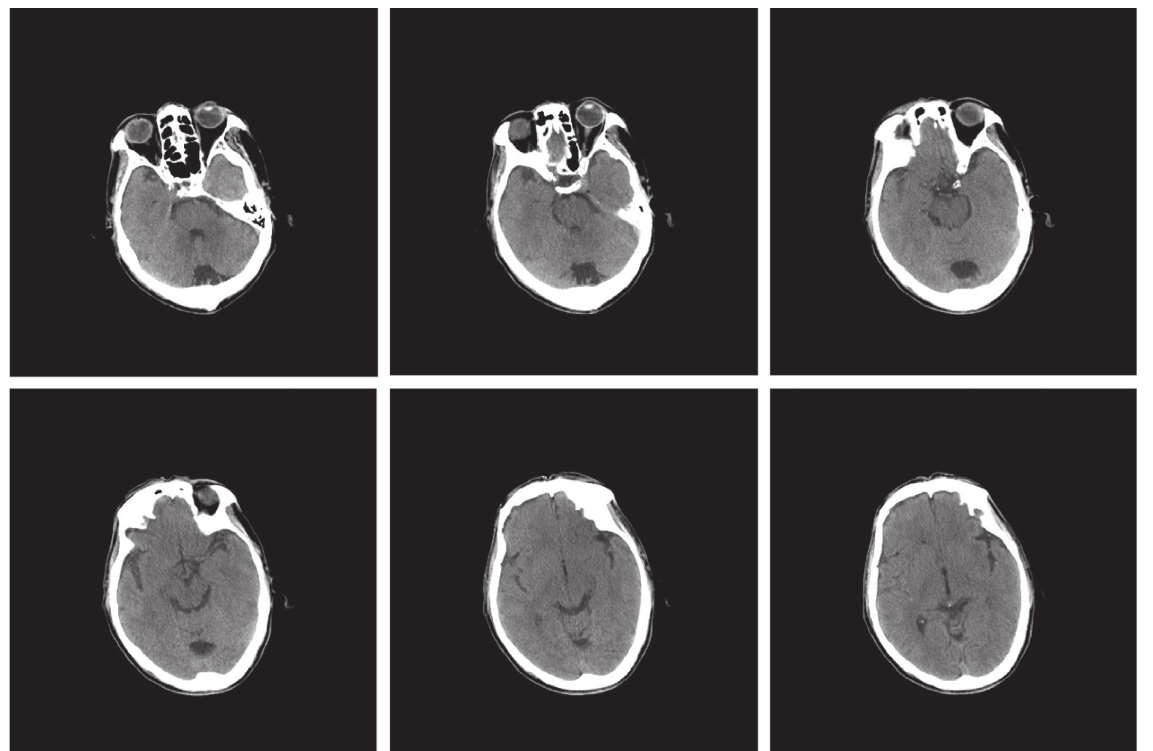
Figure 3: The CT examination in August 2nd. No blood could be